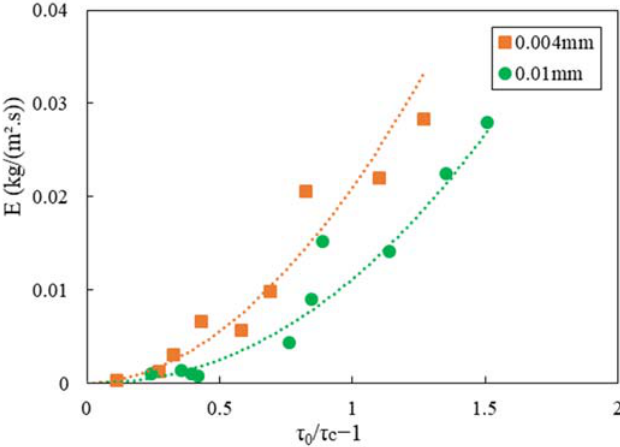
Figure 13. Relationship between relative residual shear stress and scouring rate.